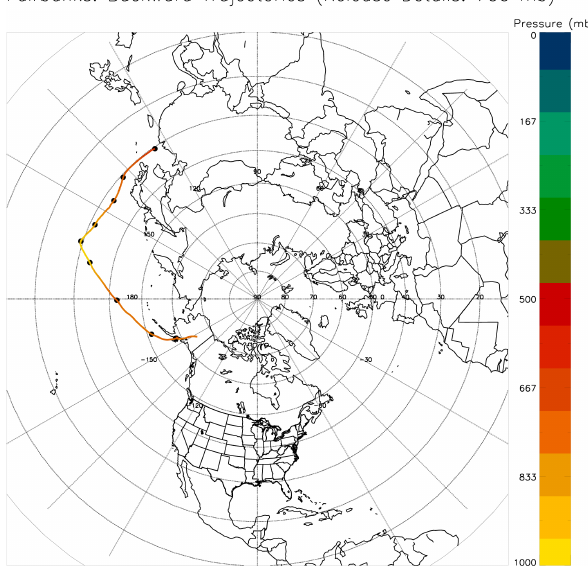
Fig. 13. FLEXPART back trajectory ending 3 April 2008 at 700hPa over Fairbanks, Alaska. Each black dot represents one day. Eleva- tion for all FLEXPART trajectories was determined using distinct layers observed in the lidar